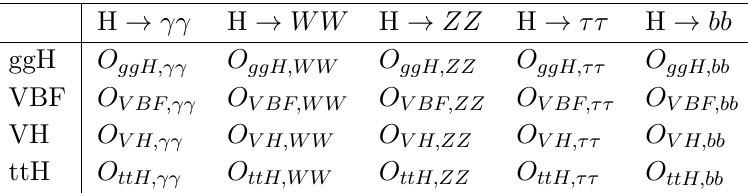
Table 1 . Rows represent the Higgs boson production modes: gluon fusion ( ggH ), vector boson fusion ( V BF ), associated production with a Z or W boson ( V H ), and associated production with a top quark pair ( ttH ). Columns represent Higgs boson decay